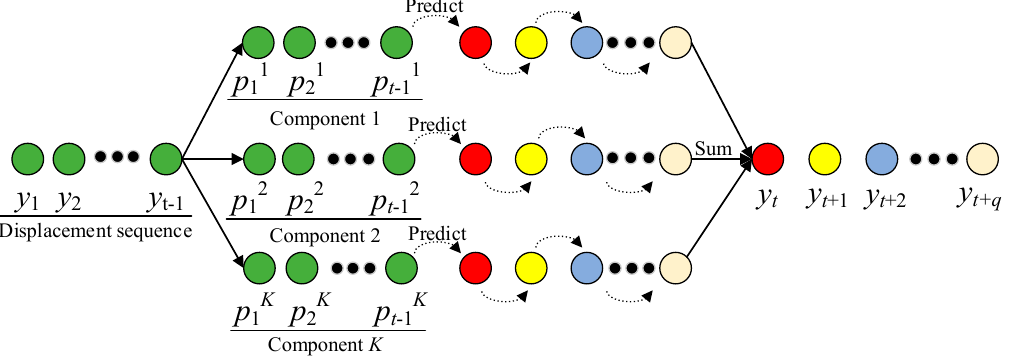
Figure 4. Dynamic forecasting process based on the VMD-SLSTM network.